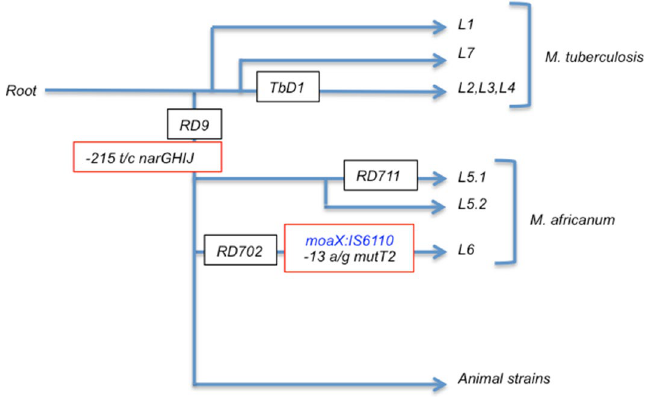
Figure 4. Partial evolutionary scenario of MTBC detailing M. africanum lineages. IS 6110 is involved in the natural evolution of MTBC, and the seemingly random transposition may have contributed to the differentiation of MTBC. Mutations and specific insertion of IS 6110 in the moaX gene found in this work are